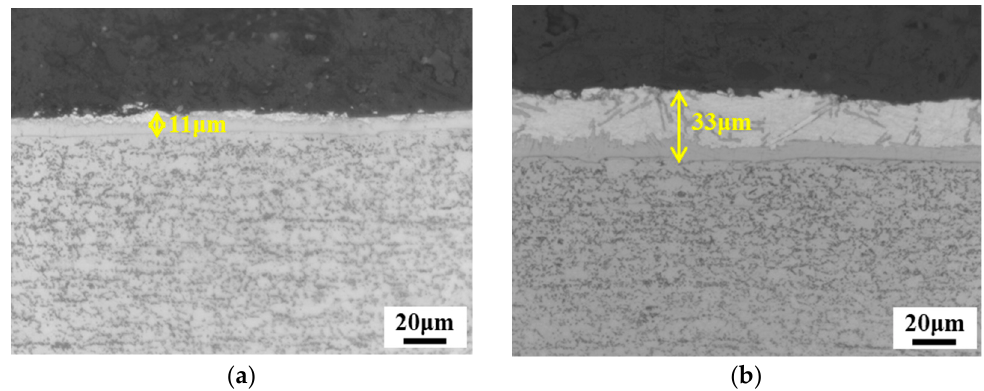
Figure 5. OM micrographs showing the coatings and microstructures before hot stamping: ( a ) Thin 1.4 ; ( b ) Thick 1.4 .